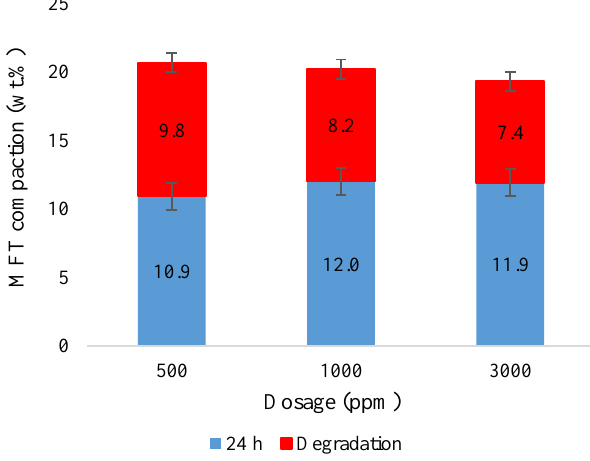
Figure 3. Comparison of compactions of 5.0 wt.% MFT in synthetic process water after treatments with poly(PLA 4 ChMA) at various dosages.